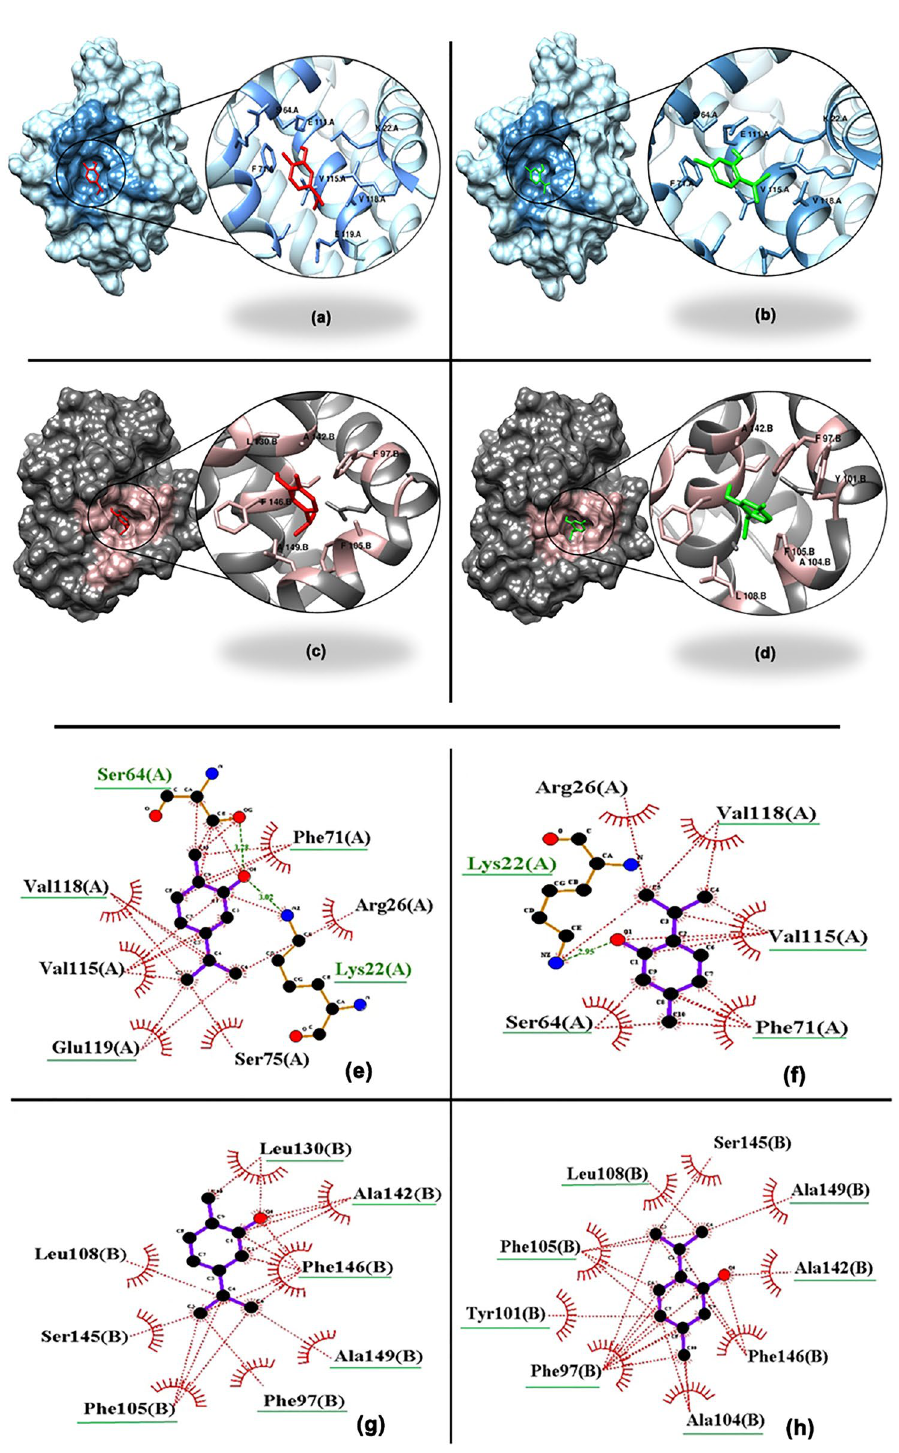
Figure 6. The 3D interaction of BCL2/carvacrol ( a ), BCL2/thymol ( b ), BCL-xl/carvacrol ( c ) and BCL-xl/ thymol ( d ). The active site of BCL2 and BCL-xl are shown with dark blue and light pink, respectively. As well, carvacrol and thymol are seen in red and green color, respectively. Binding residues are presented in large scale circles. The 2D interaction of BCL2/carvacrol ( e ), BCL2/thymol ( f ), BCL-xl/carvacrol ( g ) and BCL-xl/thymol ( h ). The involved residues, which have bonds with macromolecules, are marked with green